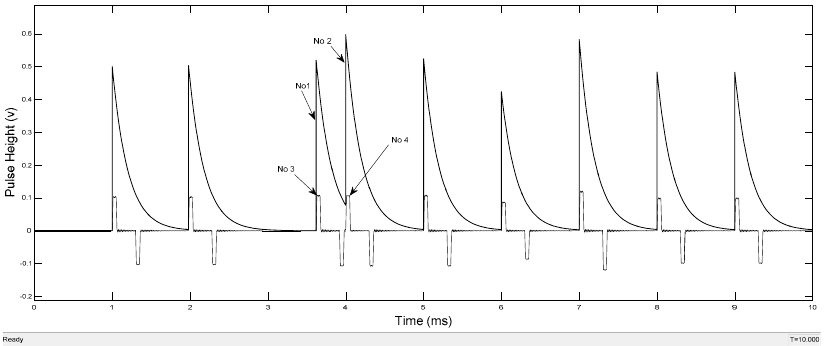
Figure 15. Pile-up 1 using the NTPS algorithm.